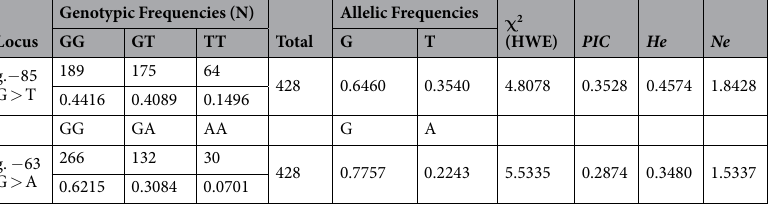
Table 1. Genotype frequencies (%) of the SIX1 gene for the SNPs in the Qinchuan cattle populations. HWE, Hardy-Weinberg equilibrium; χ 0.05 2 = 5.991, χ 0.01 2 =